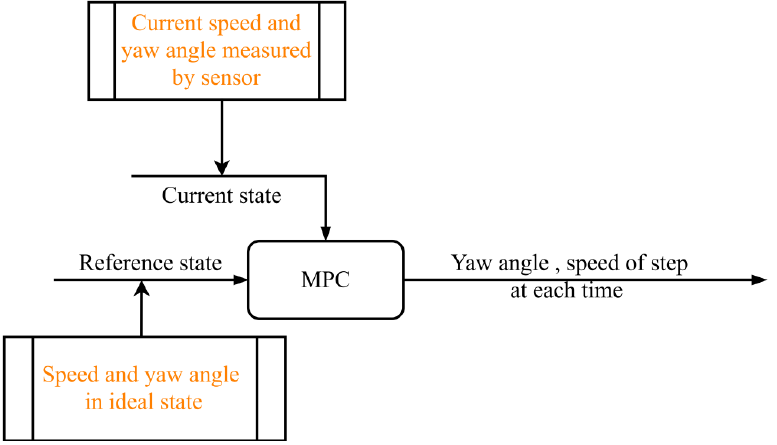
Figure 2. Input and output of MPC method for quadruped robot.